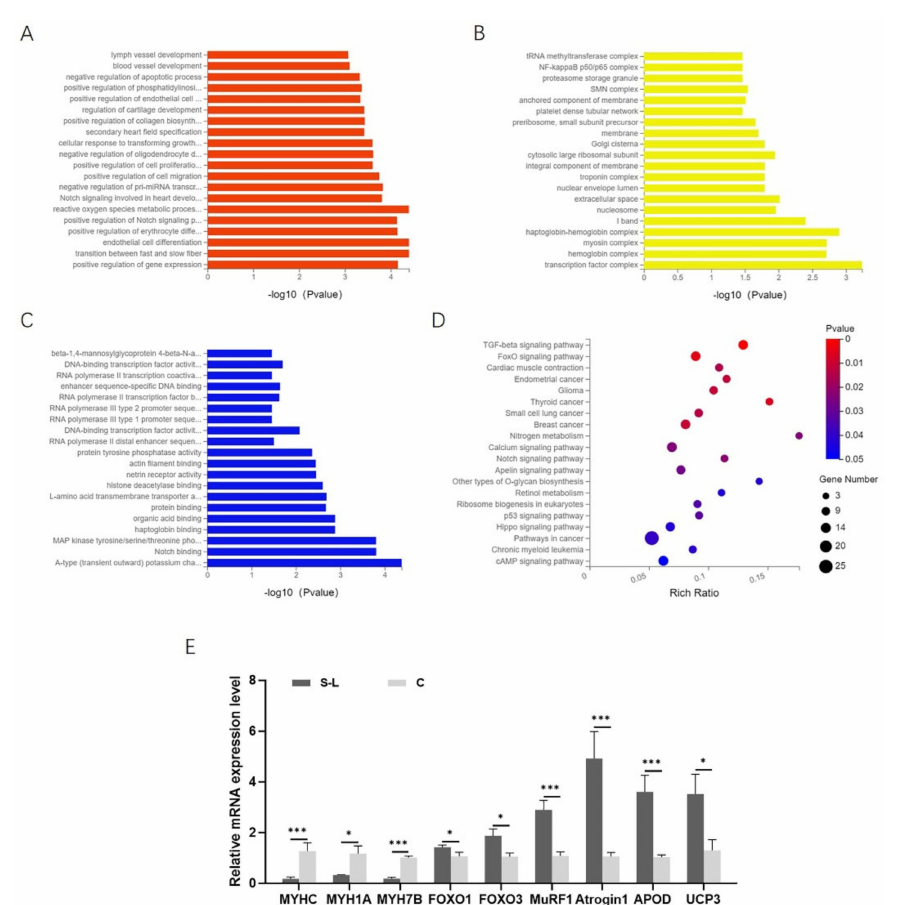
Figure 5. GO and KEGG pathway analysis for DEGs. ( A ) Top 20 terms of the biological process part of GO enrichment analysis for DEGs. ( B ) Top 20 terms of cell component part of GO enrichment analysis for DEGs. ( C ) Top 20 terms of molecular functions of GO enrichment analysis for DEG. ( D ) Top 20 enriched pathways in KEGG pathway analysis for DEGs. ( E ) Validation of transcriptome sequencing results by qPCR. Data are presented as mean ± SEM ( n = 6 biologically independent samples). * p < 0.05; *** p < 0.001 (Student’s t